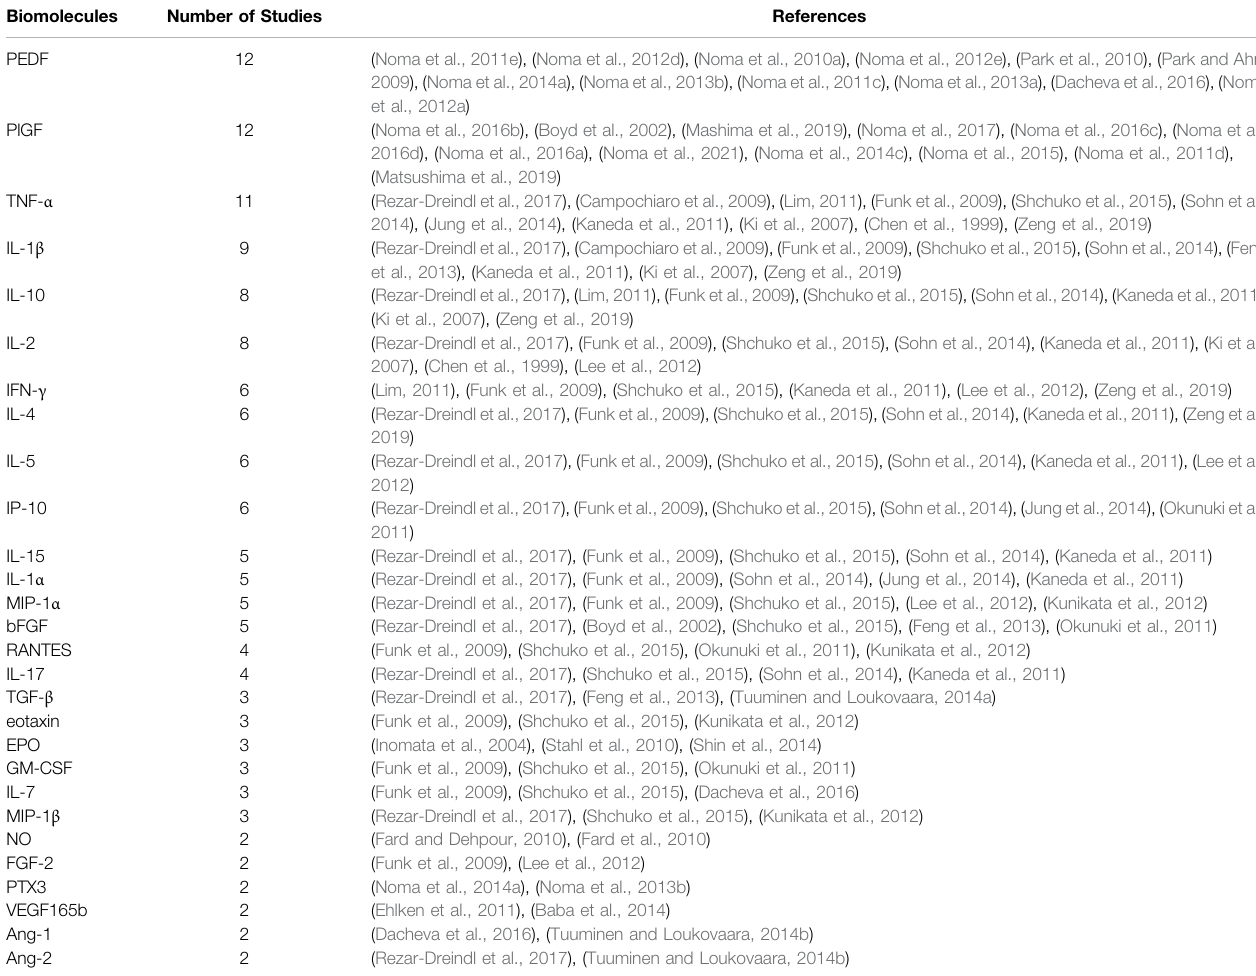
a Other biomolecules described in at least 2 independent studies are presented in this table. Abbreviations: PEDF, pigment epithelium-derived factor; PlGF, placental growth factor; TNF, tumor necrosis factor; IL, interleukin; IFN, interferon; IP, IFN- γ induced protein; MIP, macrophage in fl ammatory protein; bFGF, basic fi broblast growth factor; RANTES, Regulated upon Activation, Normal T Cell Expressed and Presumably Secreted; TGF, transforming growth factor; GM-CSF, granulocyte macrophage colony-stimulating factor; NO, nitro oxide; FGF, fi broblast growth factor; PTX3, pentraxin 3; VEGF, vascular endothelial growth factor; Ang, angiopoietin; EPO,